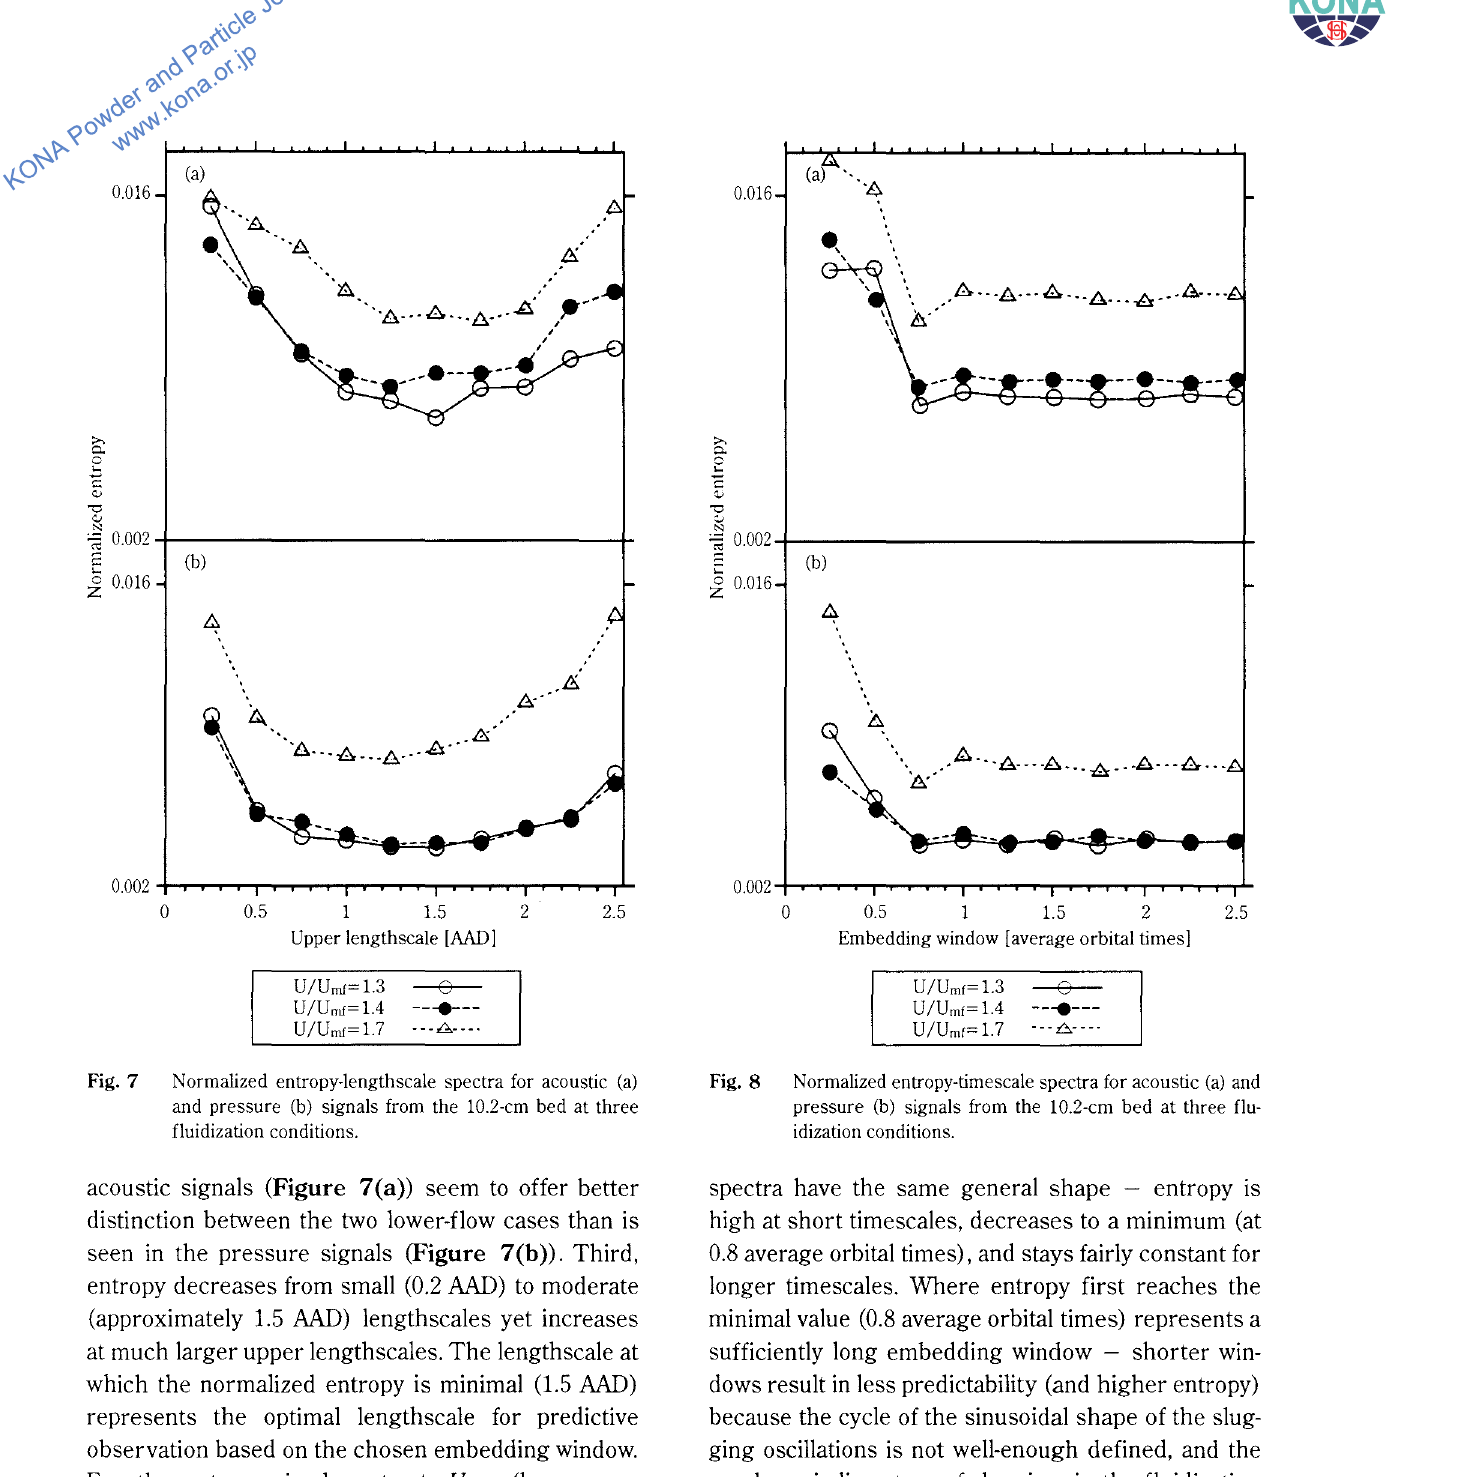
Normalized entropy-timescale spectra for acoustic (a) and pressure (b) signals from the 10.2-cm bed at three flu idization